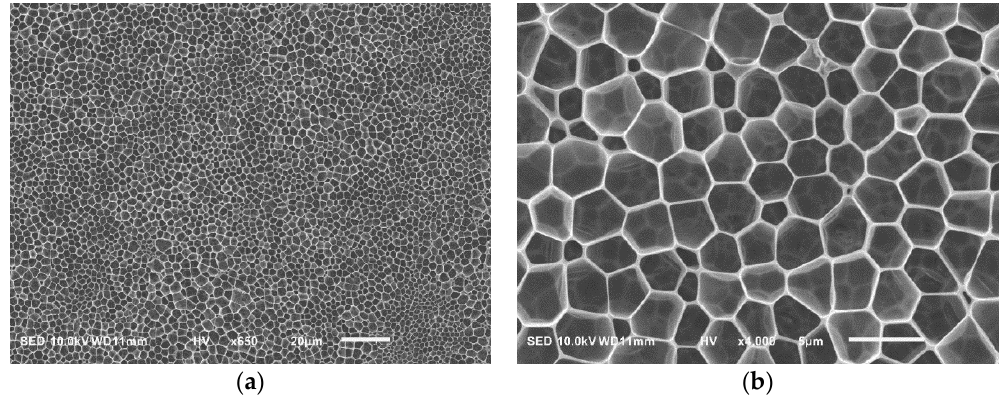
Figure 8. SEM images of BF film produced by deLG3-PSt 68k using 1:3 methanol/chloroform mixed solvent.